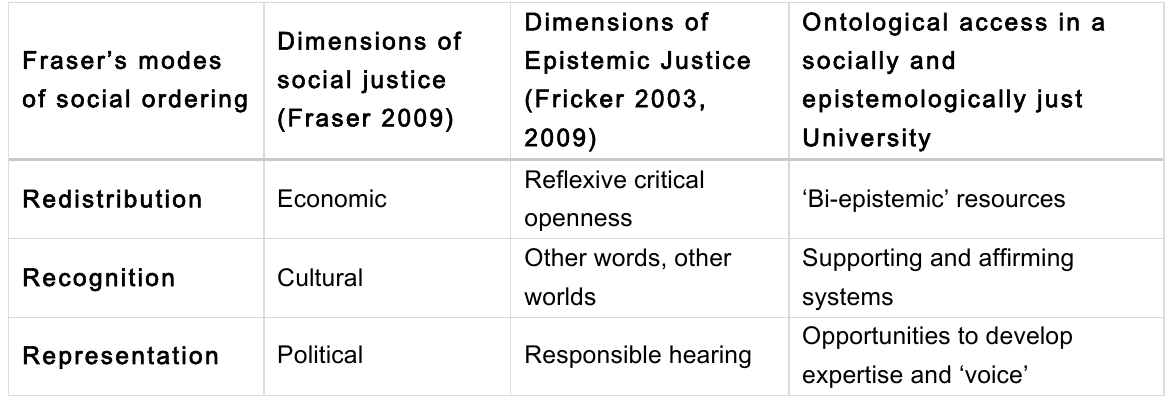
Table 1: Social and Epistemic Justice in Higher Education